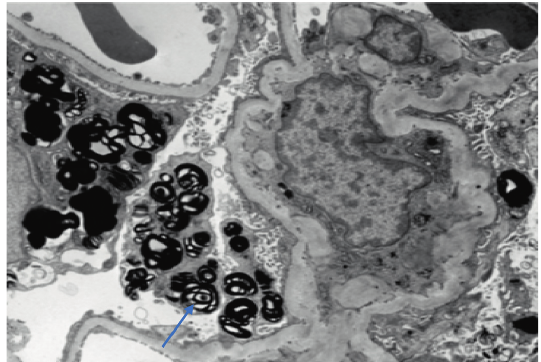
Figure 2: Electron microscopy showing podocytes containing dark lamellated osmophilic inclusions, some with appearance of zebra bodies (blue arrow). Transmission electron microscopy; original magnification